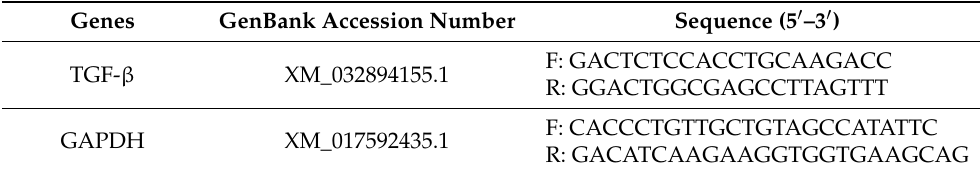
Table 1. Primers used for